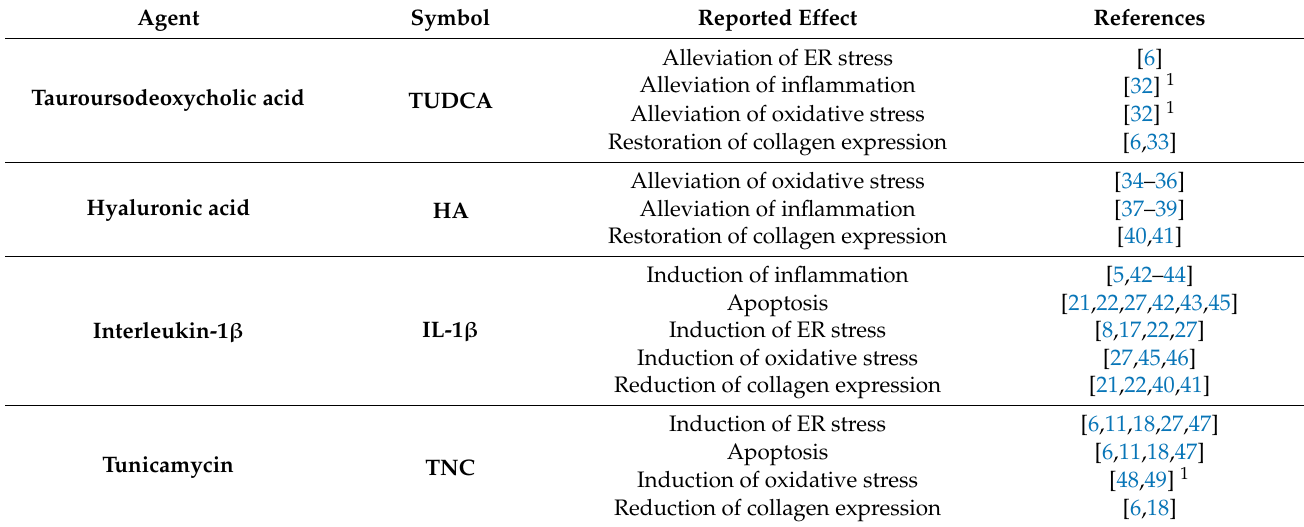
Table 1. Pharmacological agents used in the study. Previously reported effects in chondrocytes together with proper references numbers are